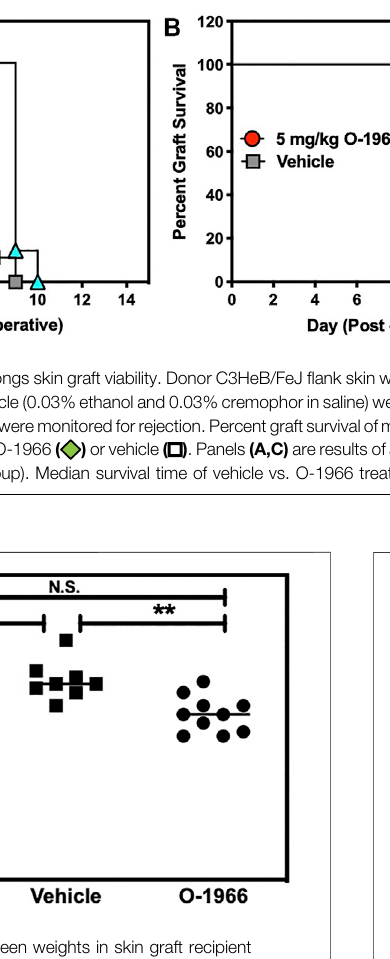
FIGURE 2 | O-1966 decreases spleen weights in skin graft recipient mice.Donor C3HeB/FeJ fl ankskin was transplanted tothe back ofarecipient C57BL/6J mice, sutured, and bandaged. Doses of O-1966 (5 mg/kg) or vehicle(0.03%ethanoland0.03%cremophorinsaline)wereinjectedi.p. every other day from 1 h pre-op to 14 days post-op. On post-op day 14, animals were sacri fi ced and spleens were removed. The spleen weight to bodyweightratiowascalculatedand isexpressed asapercentage,ofcontrol mice ( ▲ ) (n (cid:1) 9) and grafted mice treated with 5 mg/kg O-1966 ( ■ ) (n (cid:1) 8) or vehicle ( C ) (n (cid:1) 10). ** p < 0.001 for O-1966 vs. vehicle as determined by one- way ANOVA followed by Tukey ’ s multiple comparison test.